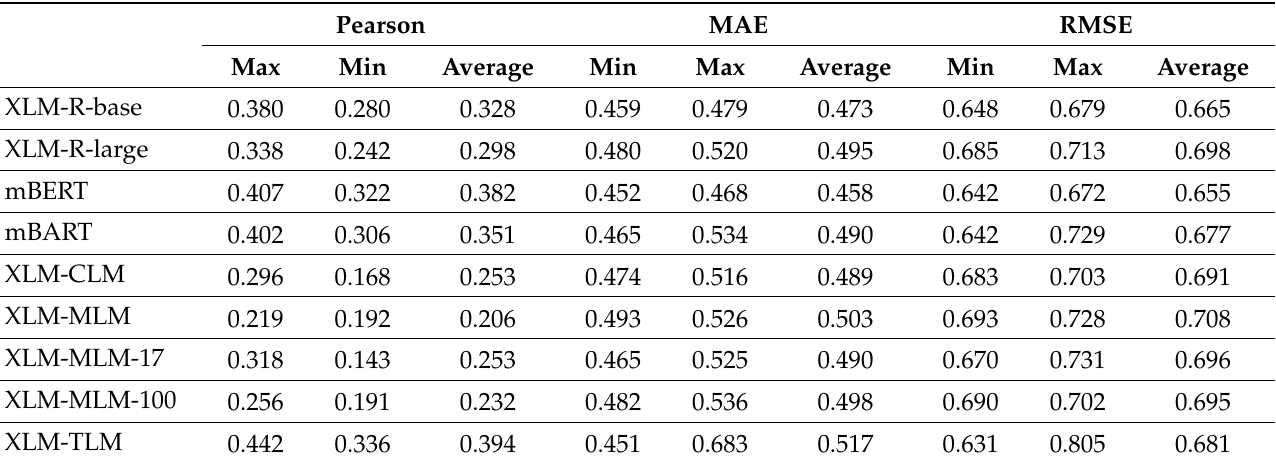
Table 2. mPLM finetuning results for the test set of the WMT20 sub-task 1. Pearson MAE